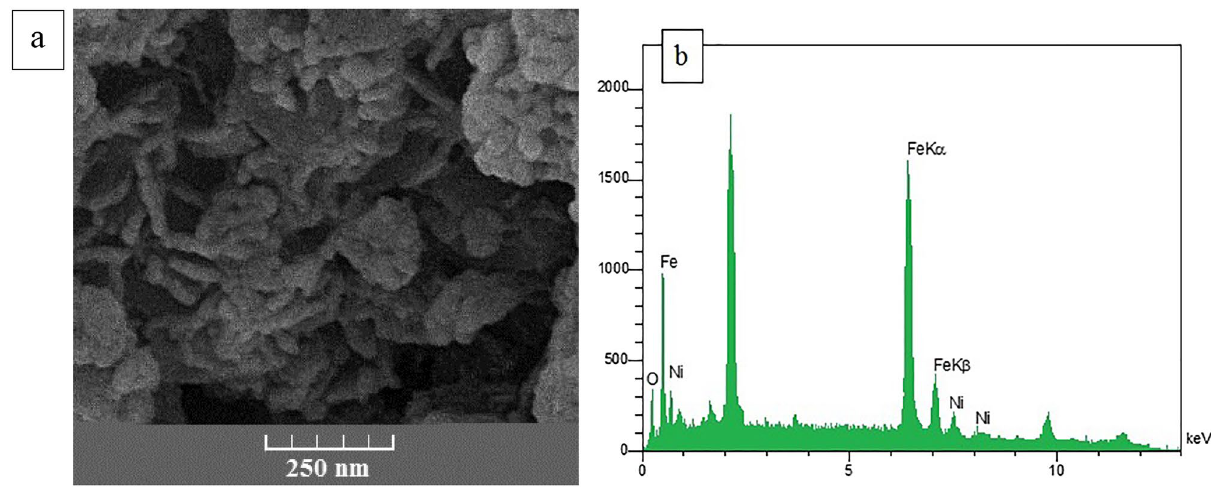
Figure 3. SEM and EDX images of green-synthesized nickel-ferrite